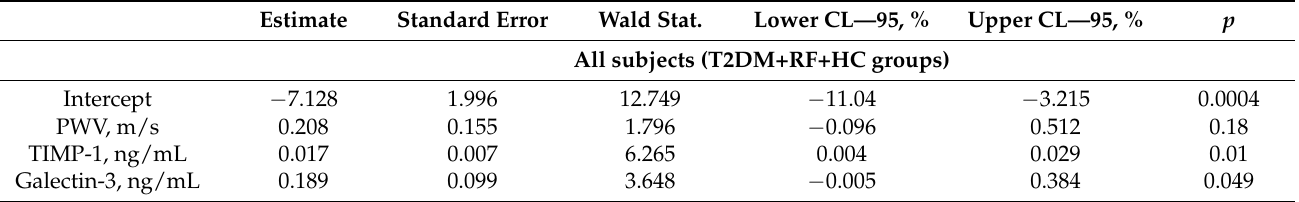
Table 5. Multivariate model with additional factors only that predicted cardiac fibrosis in all subjects (as detected by